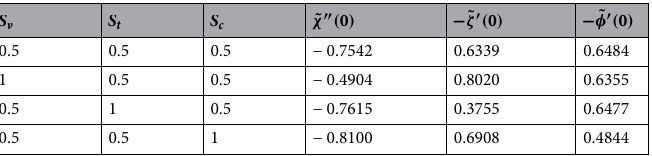
Table 4. For A = 0 and different values of S v , S t , S c with M = 3, Gr = 2, Pr = 7, Gc = 2, Ec = 0.5, and Sc = 0.6 the values of ˜ χ ′′ ( 0 ) , −˜ ζ ′ ( 0 ) , − ˜ φ ′ ( 0 ) .